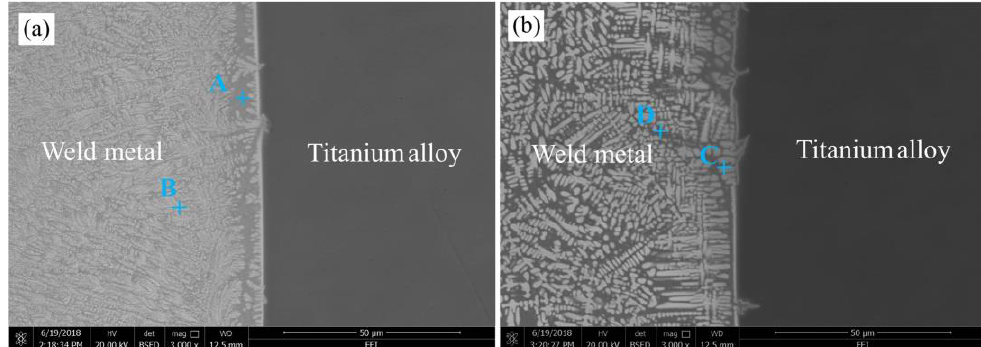
Figure 3. Microstructure of titanium alloy side interface of welded joints at welding speed of ( a ) 6 mm/s (EBW-1) and ( b ) 10 mm/s (EBW-3). 6 mm/s (EBW-1) and ( b ) 10 mm/s (EBW-3). Table 4. The main chemical compositions of different zones (at %) at titanium alloy side.